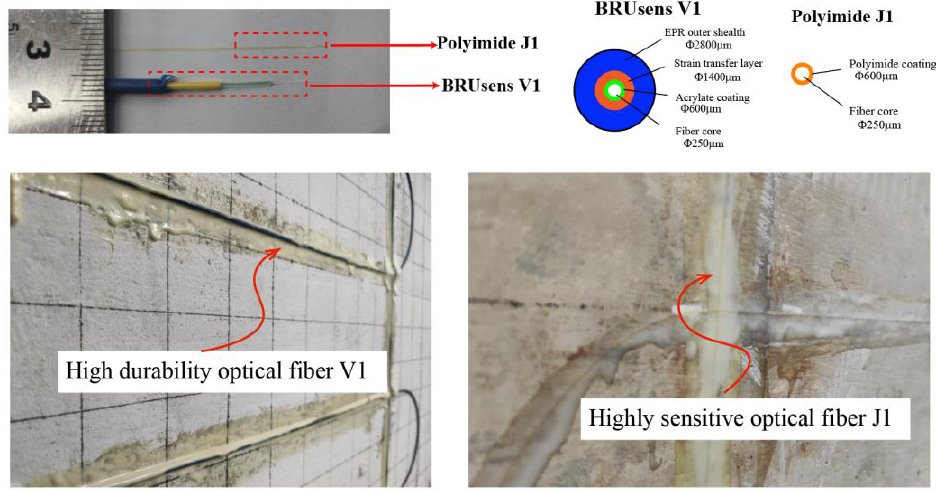
Figure 3. Field test setup of precast segmental bent cap.